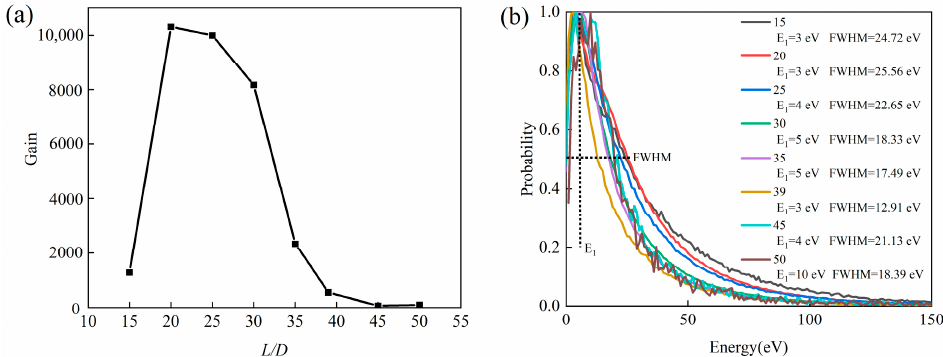
Figure 10. Effect of L / D on secondary electron multiplication at the same applied voltage (bias volt- age = 850 V, θ = 6 o , l 2 = 6 μ m): ( a ) Gain; ( b ) The most probable exit energy distribution.